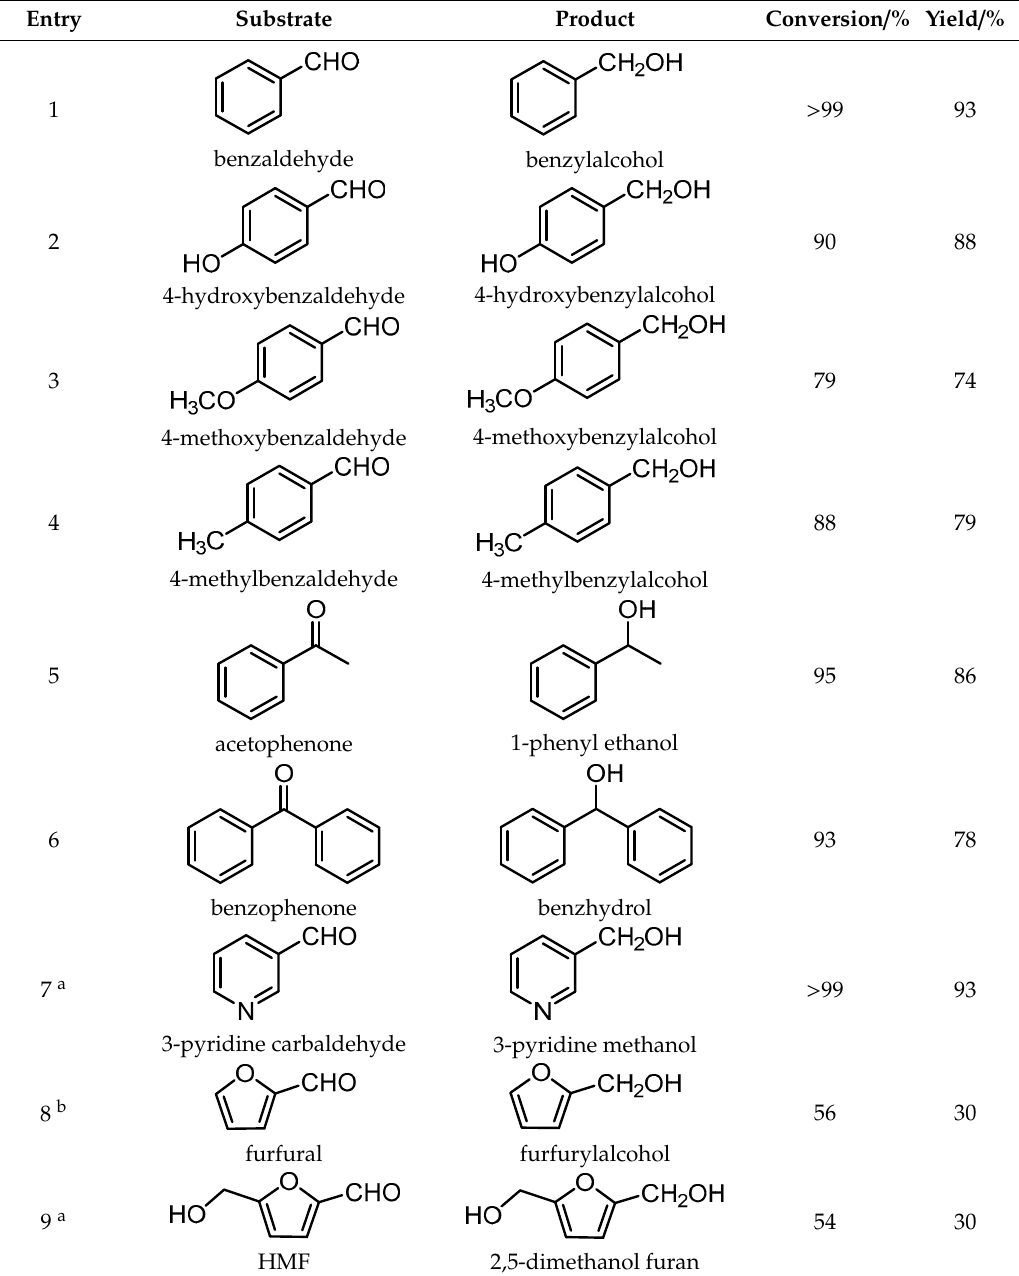
4-methoxybenzaldehyde